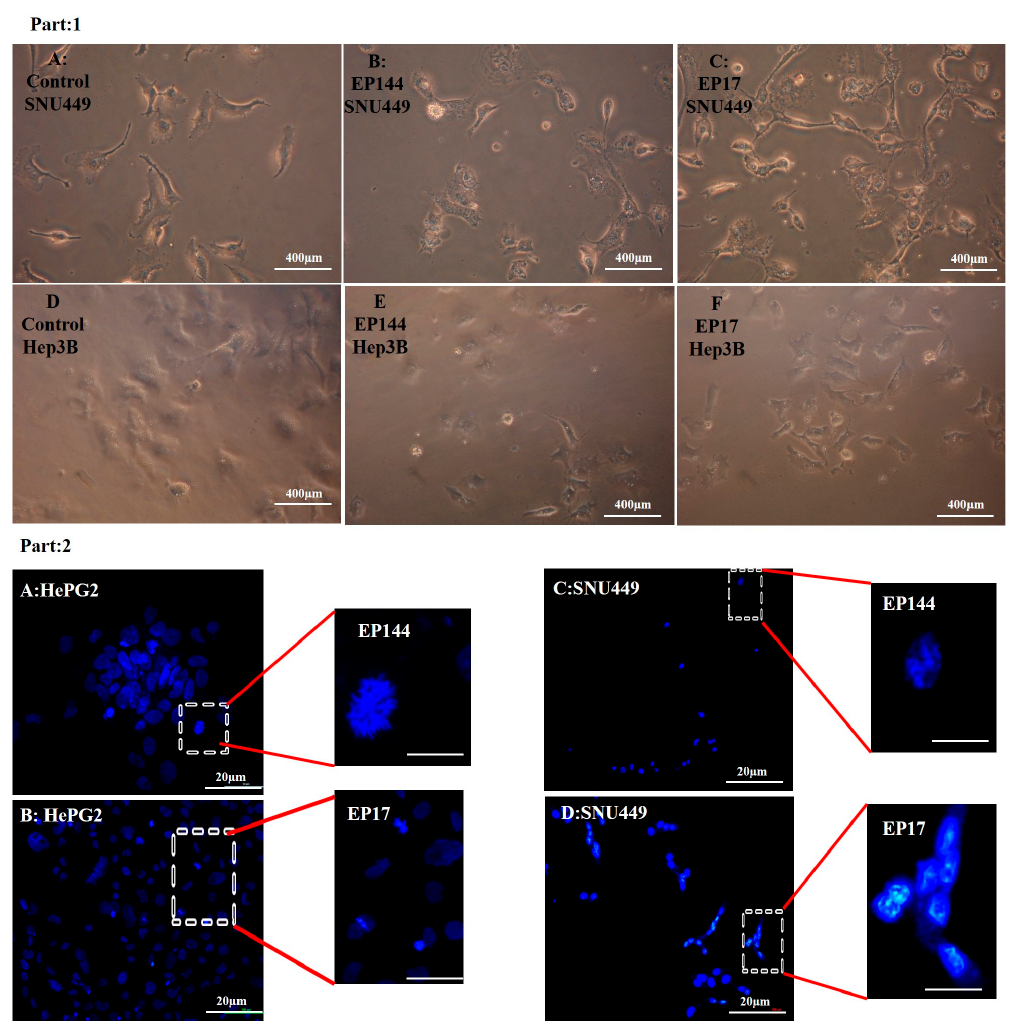
Figure 7. ( Part 1 ) SNU449 and Hep3B cell lines suffered from phenotype changes. ( A ) control SNU449. ( B ) SNU449 exposed to 50µg /ml EP144. ( C )SNU449 exposed to 50µg /ml EP17. ( D ) control Hep3B. ( E ) Hep3B exposed to 50µg /ml EP144. ( F ) Hep3B exposed to 50µg /ml EP17. ( Part 2 ) Fluorescence images of morphology of DAPI staining ( A ) Nuclear degradation at Hep3B. ( B ) Nuclear condensation at Hep3B. ( C ) Nuclear fragmentation at SNU449. ( D ) Nuclear activation at SNU449.